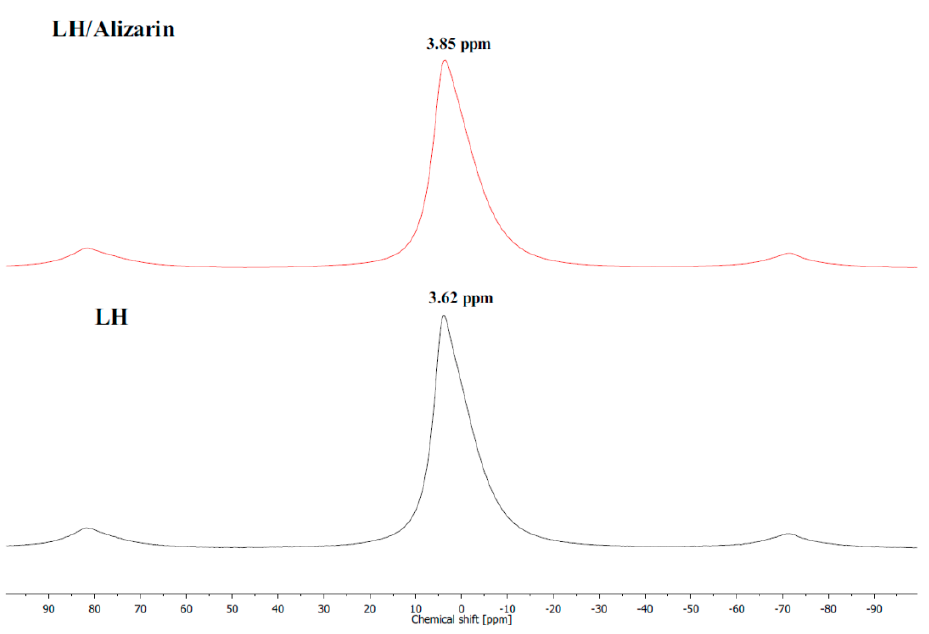
Figure 2. 27 Al MAS NMR spectra of alizarin lake before and after adsorption of alizarin dye.